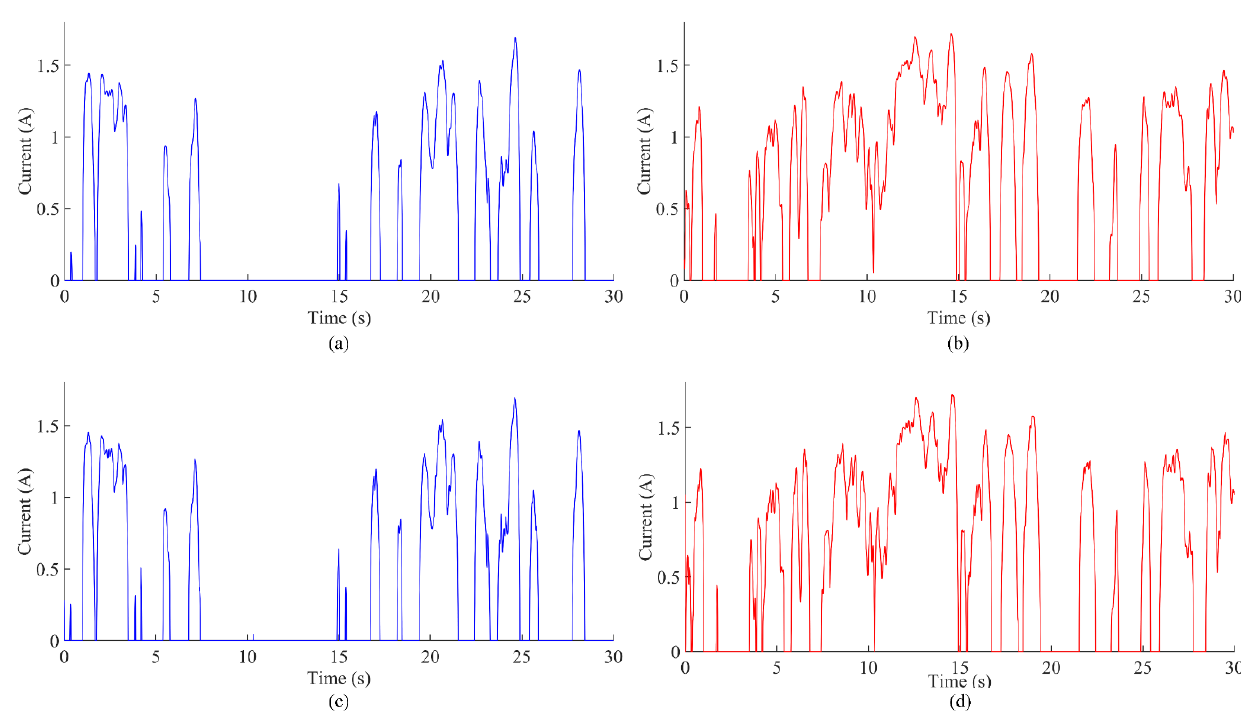
Figure 18. ( a ) Current value of the upper electromagnet under the state feedback control without interference; ( b ) current value of the lower electromagnet under the state feedback control without interference; ( c ) current value of the upper electromagnet under the integral sliding mode control without interference; ( d ) current value of the lower electromagnet under the integral sliding mode control without interference.